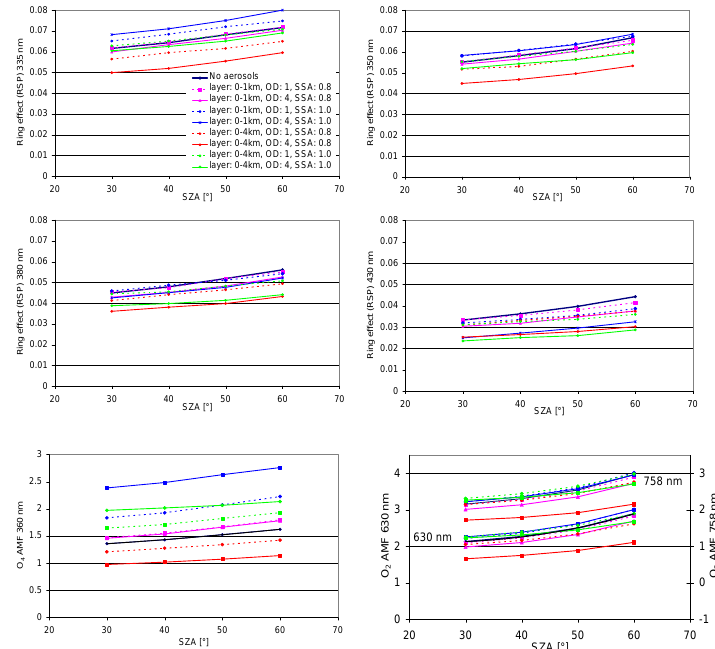
Fig. A1 Modelled dependence of the Ring effect and the O 2 and O 4 absorptions on the solar zenith angle. The calculations are performed for a viewing angle of -90° (nadir geometry), aerosol asymmetry parameter of 0.68, and surface albedo of 10% for 630 nm, 20% for 758nm, and 5% for all other wavelengths.